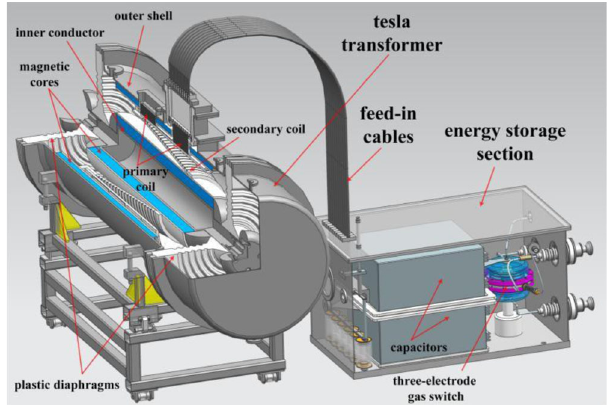
FIG. 2. Schematic view of the energy storage section and tesla transformer. Both the volumes of the energy storage bank and tesla transformer are filled with transformer